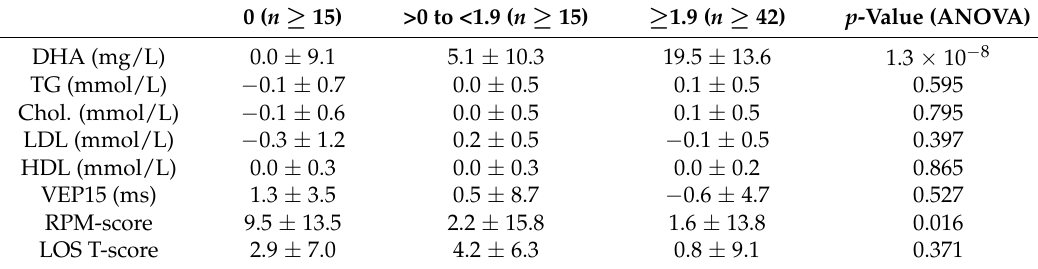
Table 3. Change of TG, Chol., LDL, HDL, VEP15, RPM-score, and LOS T-score during the intervention period, stratified into three groups according to the daily dosage of DHA (0, >0 to <1.9, ≥ 1.9 mg/kg&day); changes in the three groups were compared by ANOVA. 0 ( n ≥